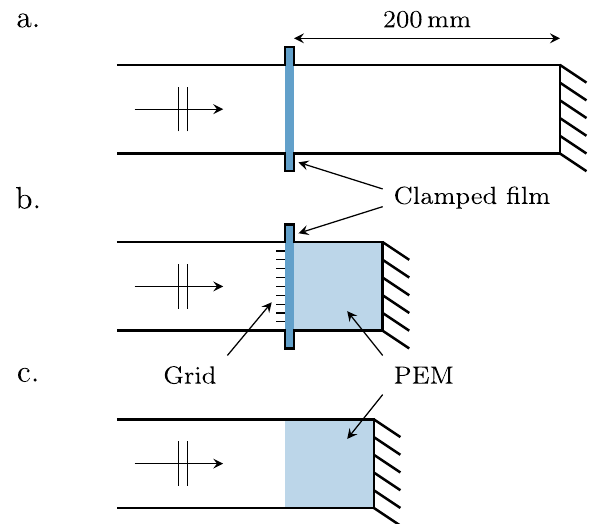
Figure 8. Schematics of the different measurement set-ups. The incident wave is a plane wave, travelling normal to the sample ’ s surface. A three-microphones method is used, one being mounted through the rigid backing, the two others on the side wall between the source and the sample.